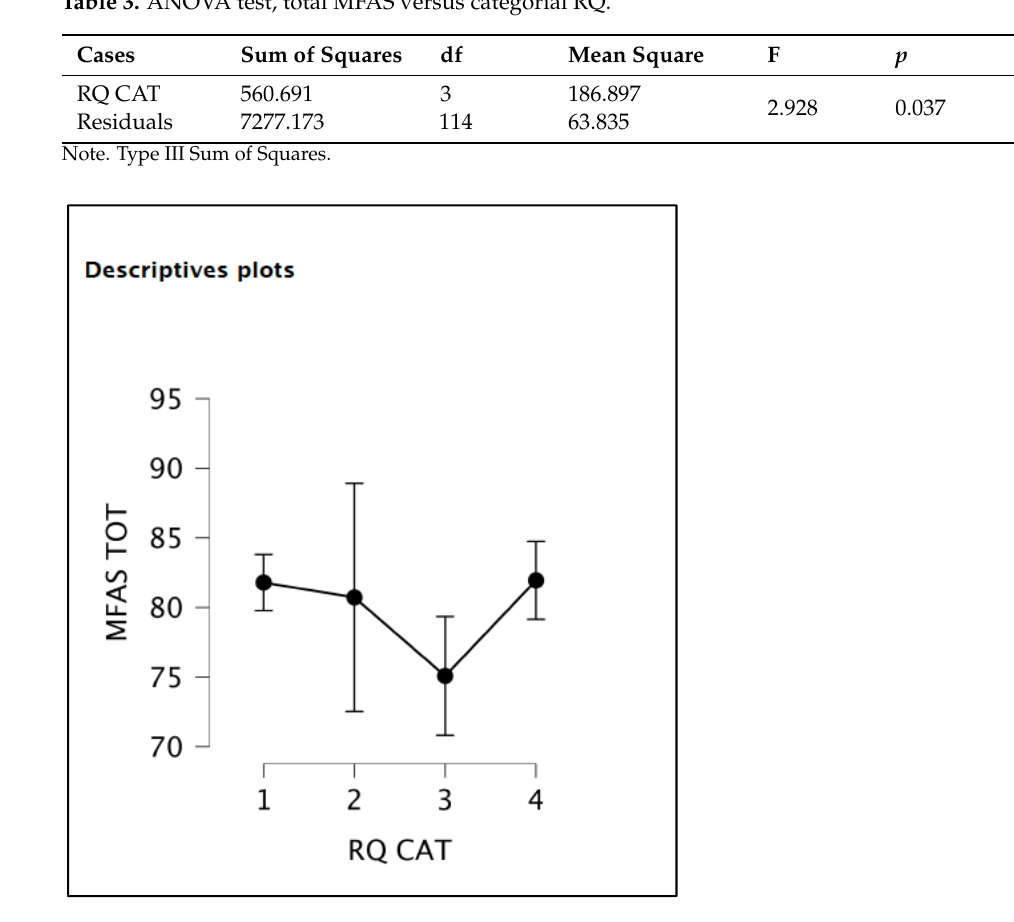
Figure 1. A descriptive plot of the MFAS mean score among the four RQ subscales. As reported in Table 4, the correlation analyses (Pearson r two-tailed) demonstrated that the MFAS score was significantly and negatively related to the RQ- RQ3 fearful subscale (r = − 0.253, p = 0.006). In addition, the DAS total score (r = 0.182, p = 0.049) was significantly and positively related to the MFAS score. Table 4. Correlation analysis between MFAS score and age, DAS, EPDS, STAI Y 1-2, RQ1-4 subscales, and PBI